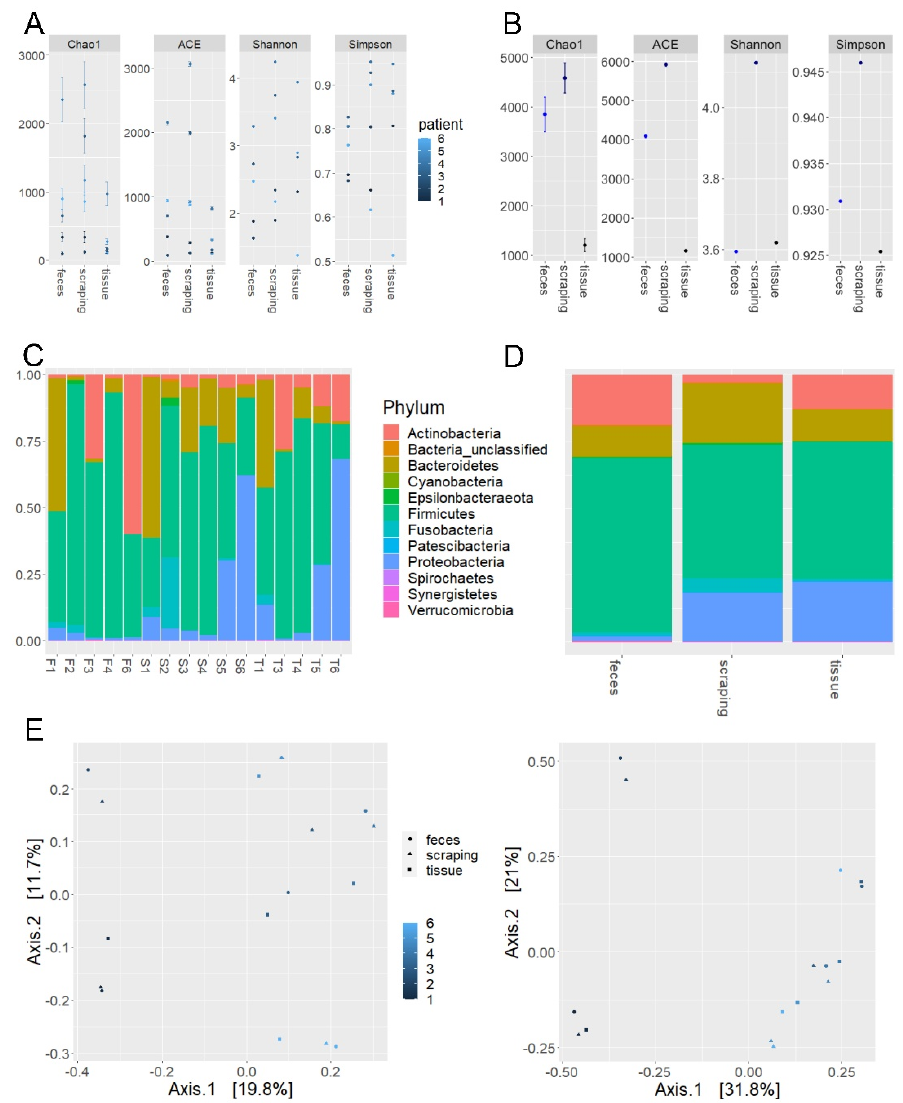
Figure 1. Alpha-diversity measures for all samples from ( A ) feces, scrapings as well as mucosa tissue and ( B ) between sample collection sites of trial step 1 experiments. Abundance on phylum level for ( C ) all individual samples from feces [F], scrapings [S], mucosa tissue [T] and ( D ) the same samples stratified according to sample site (number of reads normalized using median sequencing depth). Principal coordinate analysis based on weighted ( E ) and un-weighted ( F ) UniFrac distances for fecal samples, tissue samples and mucosal scrapings.